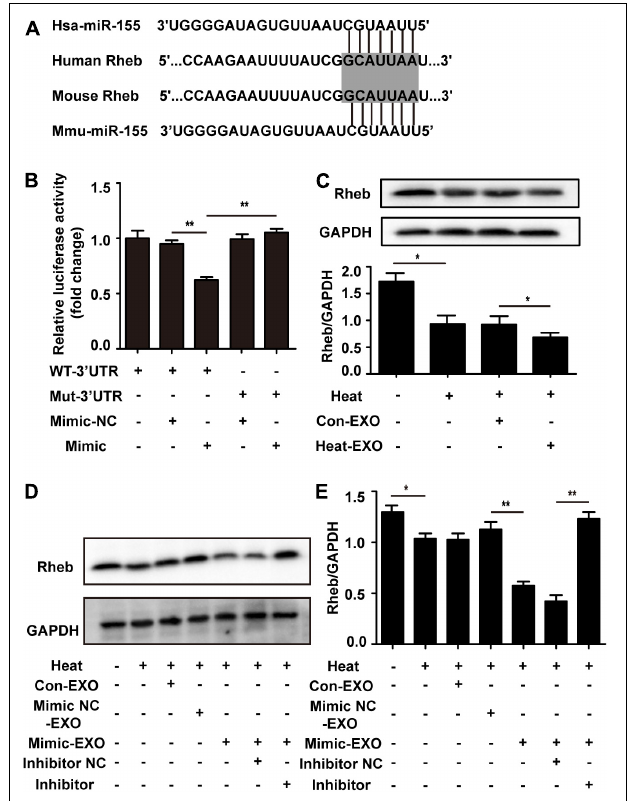
FIGURE 6 | Microglial exosomal miR-155 enhanced neuronal autophagy by targeting Rheb. (A) A potential binding site for human and mouse miR-155 in the Rheb 3 (cid:48) UTR. The seed region is highlighted. (B) The luciferase reporter plasmids carrying the WT or Mut 3 (cid:48) UTR of Rheb were cotransfected with either the miR-155 mimic or miR-155 mimic-NC into N2a cells, after 24 h, luciferase activity was detected. (C) N2a cells which cultured alone or incubated with exosomes (50 µ g/ml) derived from sham or heat exposure treated microglia for 24 h to allow enough exosomal taken-up, and then subjected to heat exposure at 42 ◦ C for 2 h, followed by a 6 h recovery period at 37 ◦ C. The protein expression of Rheb in N2a cells was determined by Western blotting. Densitometric analysis was performed. (D) N2a cells pretreated with or without miR-155 inhibitor or its negative control, and then incubated with exosomes (50 µ g/ml) derived from BV-2 cells which do not received any treatment, miR-155 mimic or miR-155 mimic negative control transfection, respectively. After that, cells were subjected to heat exposure at 42 ◦ C for 2 h, followed by 6 h recovery period at 37 ◦ C. Then the protein expression of Rheb in N2a cells was determined by Western blotting. (E) Densitometric analysis was performed. All data are presented as mean ± SD of three independent experiments at least. * p < 0.05; ** p <